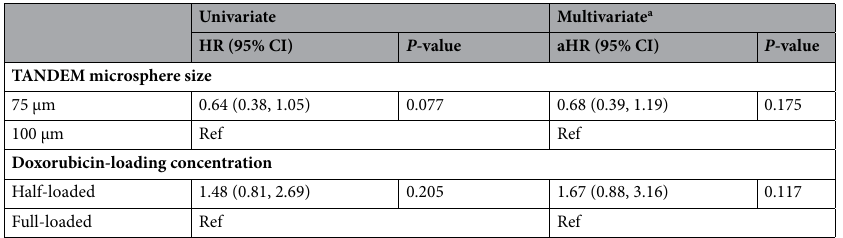
Table 6. Association of microsphere size and doxorubicin-loading concentration with overall survival in HCC patients. a Cox proportional hazards regression analysis was performed with adjustment for age, gender, CLIP stage, Child–Pugh Score, and total doxorubicin dosage. HR hazard ratio, aHR adjusted hazard ratio, CI confidence interval, ref reference.